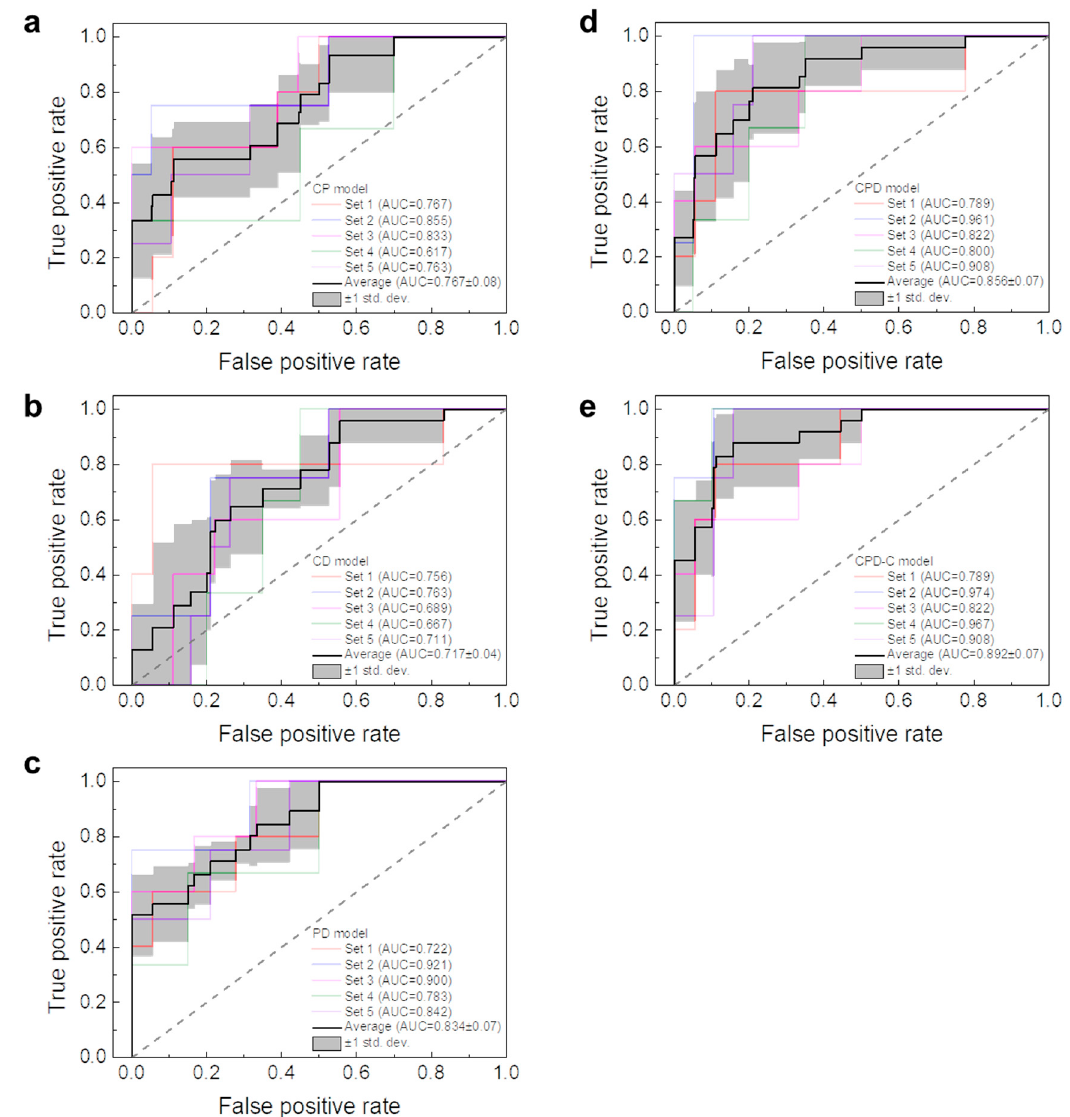
Figure 3. ROC curves of: ( a ) CP (CT+PET), ( b ) CD (CT+Dose), ( c ) PD (PET+Dose), ( d ) CPD (CT+PET+Dose), and ( e ) CPD-C (CT+PET+Dose+clinical factors) models.